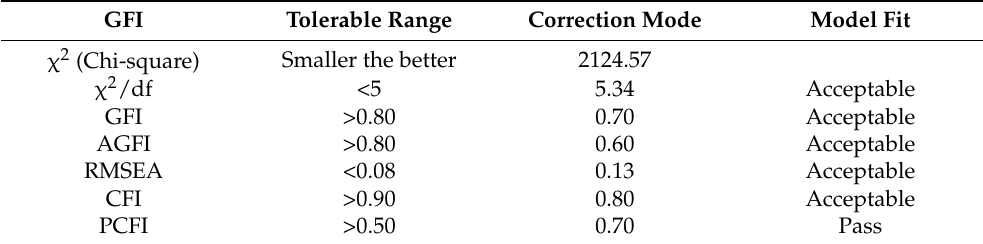
Table 6. Fit analysis of the overall model.